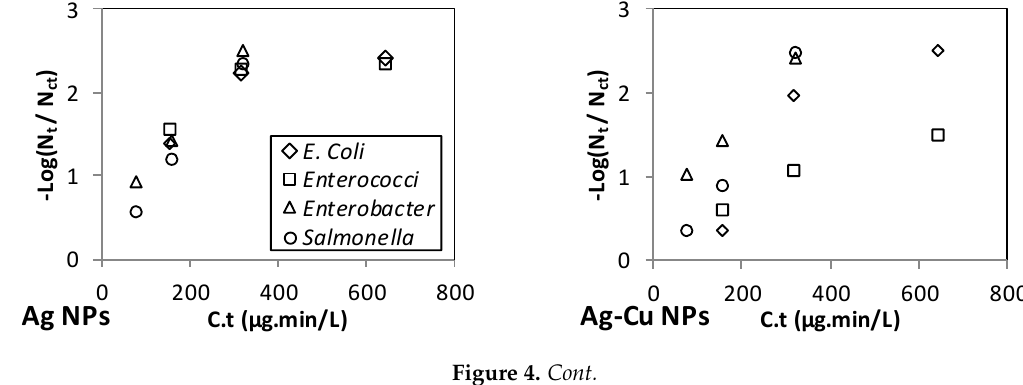
Figure 3. Effect of C.t on the inactivation of E. coli , Enterococci , Enterobacter , and Salmonella in the spiked RO permeates.